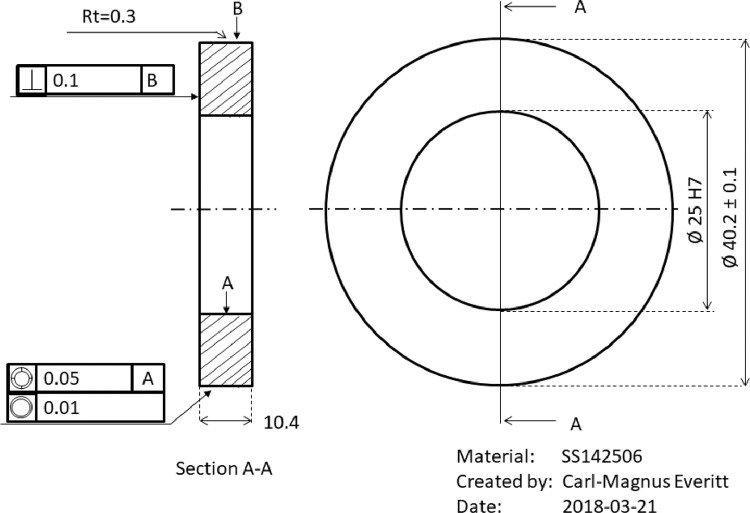
The asperity-disc.